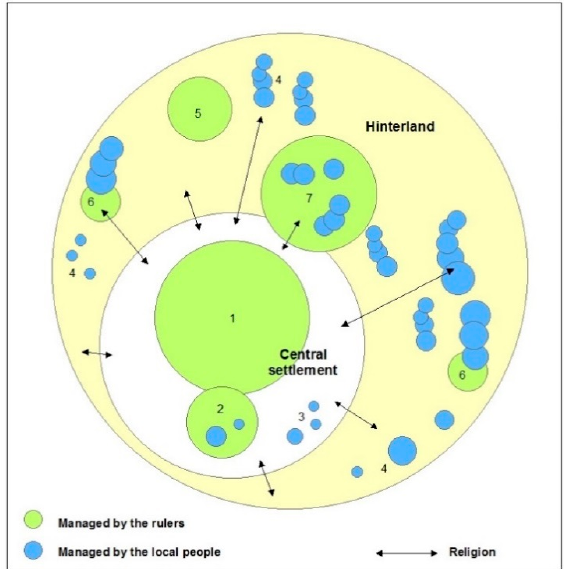
Figure 8. Ancient water management and governance in Anuradhapura. (1) Totally managed irrigation works by the central bureaucracy such as citadel and the major ring of irrigation (2) Local involvement within the central bureaucracy in irrigation management; agricultural landscape at the periphery of the main settlement. (3,4) Locally governed small tank systems within the main settlement and the hinterland. (5) Centrally managed major irrigation works in the hinterland. (6) Combined management by rulers and local people. (7) Locally managed small tank systems within the large-scale irrigation schemes covering wider regions; ex—the Kalawewa Jaya Ganga scheme covering a wider area and linking large tanks, canals and small tank cascades in the main settlement and